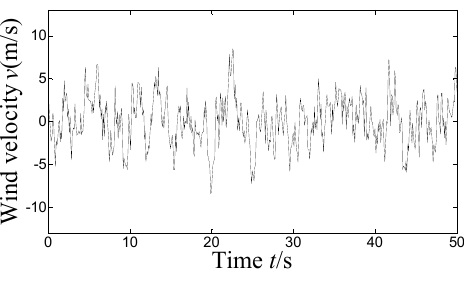
Figure 3. Fluctuating wind time ‐ history .